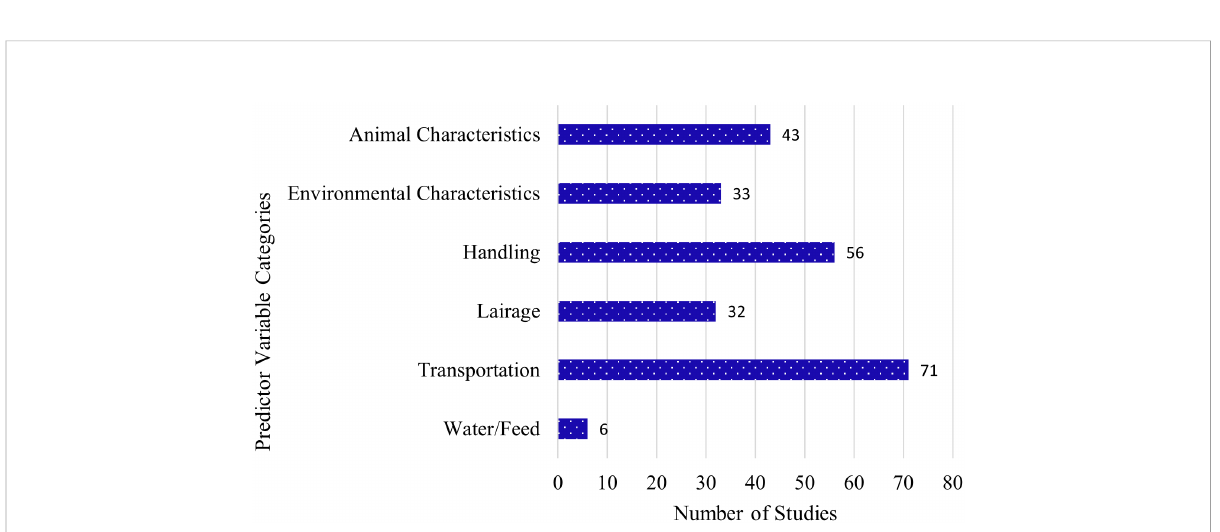
FIGURE 3 Number of studies per each predictor category included in the fi nal scoping review analysis out of the total collection ( n = 69 1 ). 1 Several studies reported multiple factors within each category, therefore the total number of variables reported in each category represent more than total studies included in the